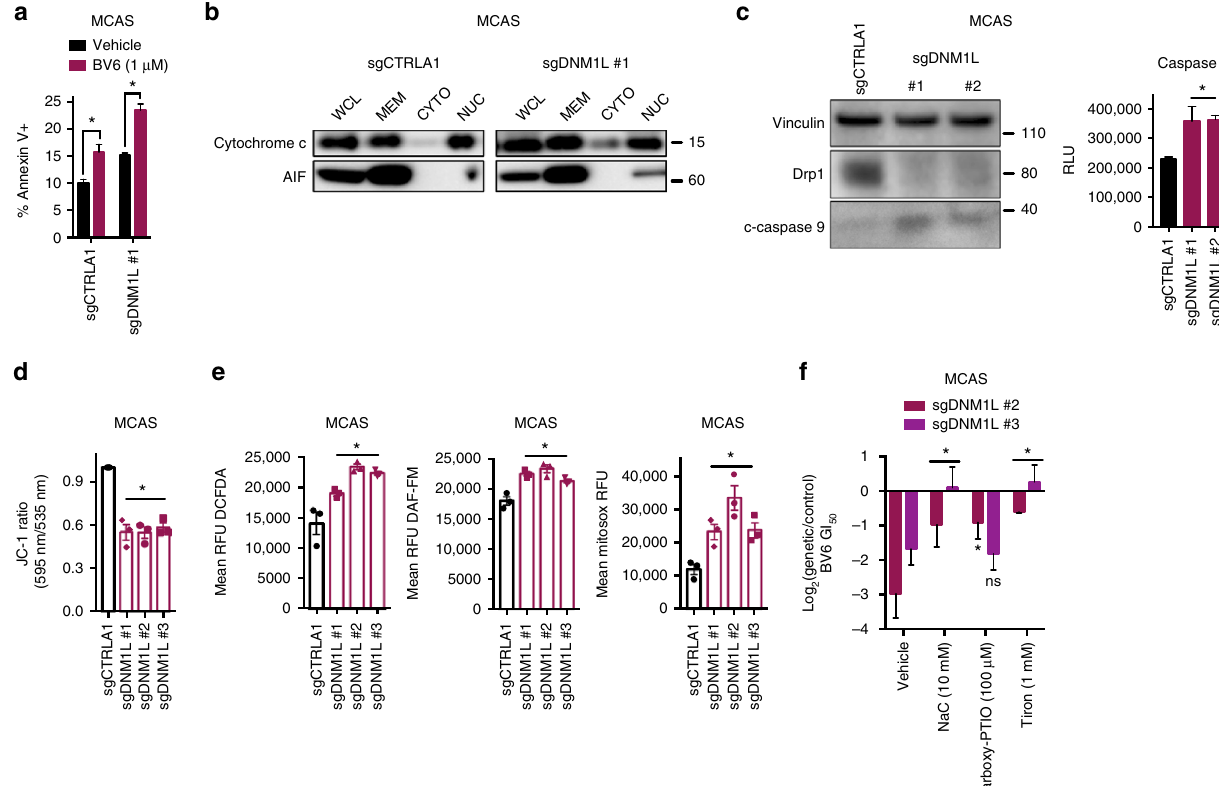
Fig. 4 DNM1L loss leads to release of cytochrome c into the cytosol resulting in low-level caspase cleavage. a Percentage of annexin V + MCAS cells transduced with a control targeting sgRNA or a sgRNAs targeting DNM1L ( n = 3). Data are mean ± SEM. * p < 0.05 by Student ’ s t -test. b Immunoblot of cytochrome c or AIF in whole-cell lysate, membrane fraction, cytosolic fraction, and nuclear fraction of MCAS cells transduced with a control sgRNA or a representative sgRNA targeting DNM1L . Immunoblots are representative of three independent experiments. AIF is used as a control for contamination of the cytosolic fraction. c Left, immunoblot of vinculin, Drp1, and c-caspase 9 in MCAS cells transduced with control sgRNA or two independent sgRNAs for DNM1L . Immunoblots are representative of two independent experiments. Right, raw luminescence units of caspase 9 activity in MCAS cells transduced with control sgRNA or two independent sgRNAs for DNM1L ( n = 3). Data are mean ± SEM. * p < 0.05 by one-way ANOVA. d Ratio of JC-1 fl uorescence (595 nm/535 nm) in MCAS cells transduced with control sgRNA or three independent sgRNAs for DNM1L ( n = 3). Data are mean ± SEM. * p < 0.05 by one- way ANOVA. e Left, DCFDA raw fl uorescence units minus no stain fl uorescence units in MCAS cells transduced with control sgRNA or three independent sgRNAs for DNM1L ( n = 3). Data are mean ± SEM. * p < 0.05 by one-way ANOVA. Middle, DAF-FM raw fl uorescence units minus no stain fl uorescence units in MCAS cells transduced with control sgRNA or three independent sgRNAs for DNM1L ( n = 3). Data are mean ± SEM. * p < 0.05 by one-way ANOVA. Right, mitosox raw fl uorescence units minus no stain fl uorescence units in MCAS cells transduced with control sgRNA or three independent sgRNAs for DNM1L ( n = 3). Data are mean ± SEM. * p < 0.05 by one-way ANOVA. f Log 2 (sgDNM1L/sgCTRLA1) BV6 GI 50 value in MCAS cells treated with either vehicle or one of the following: NaC (10 mM), Tiron (1 mM), Carboxy-PTIO (100 μ M) ( n = 3). Data are mean ± SEM. * p < 0.05 by one-way